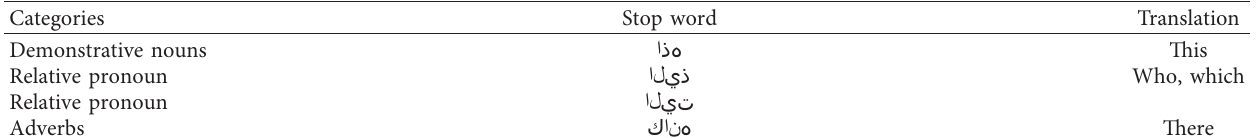
Table 7: Examples of stop words.